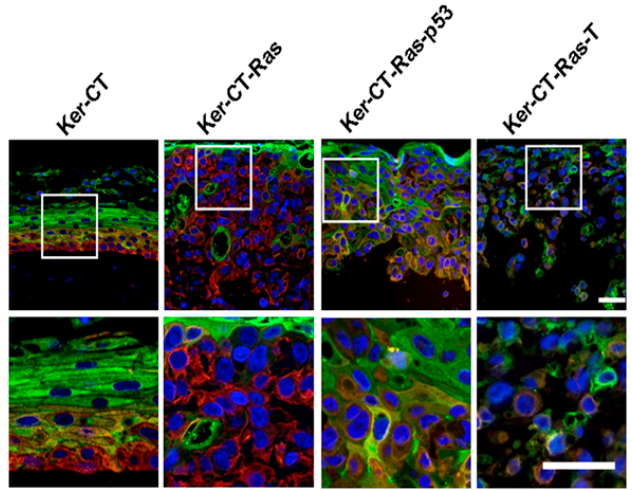
Figure 6. Double-staining performed in 21 days skin graft with keratin-14 red) and involucrin (green) stained the lowermost and uppermost layers respectively. Some evidence of co-localization (yellow to orange) in the intermediate layers was found. Both stains were found to be partially retained in Ker-CT-Ras keratinocytes, but were far less in Ker-CT-Ras-p53 keratinocytes. Scale bar: 40 µm. Reprinted under open access distribution license from [100].